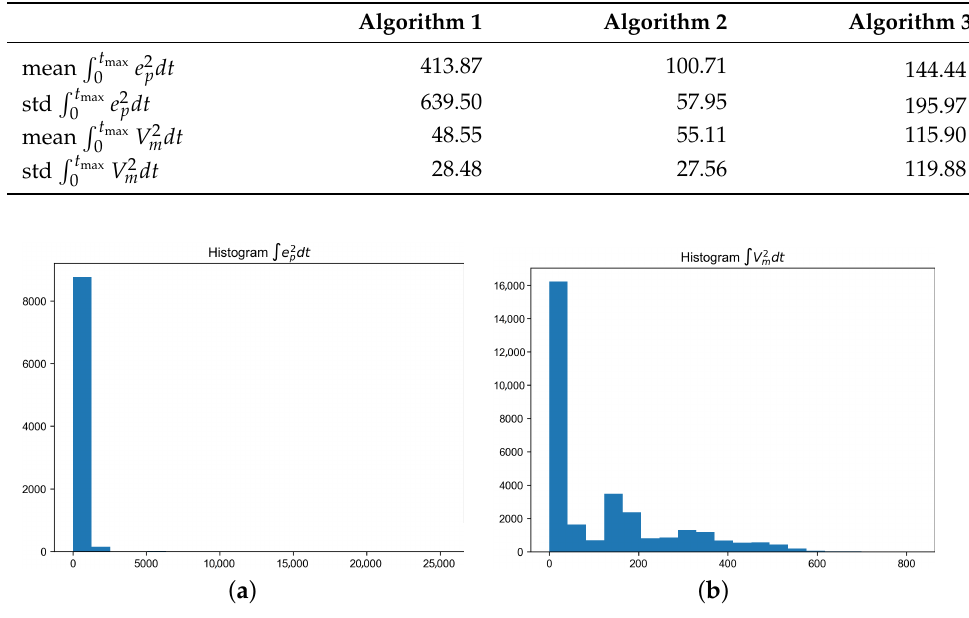
Figure 9. Algorithm 1—distributions of performance factors (histograms): ( a )